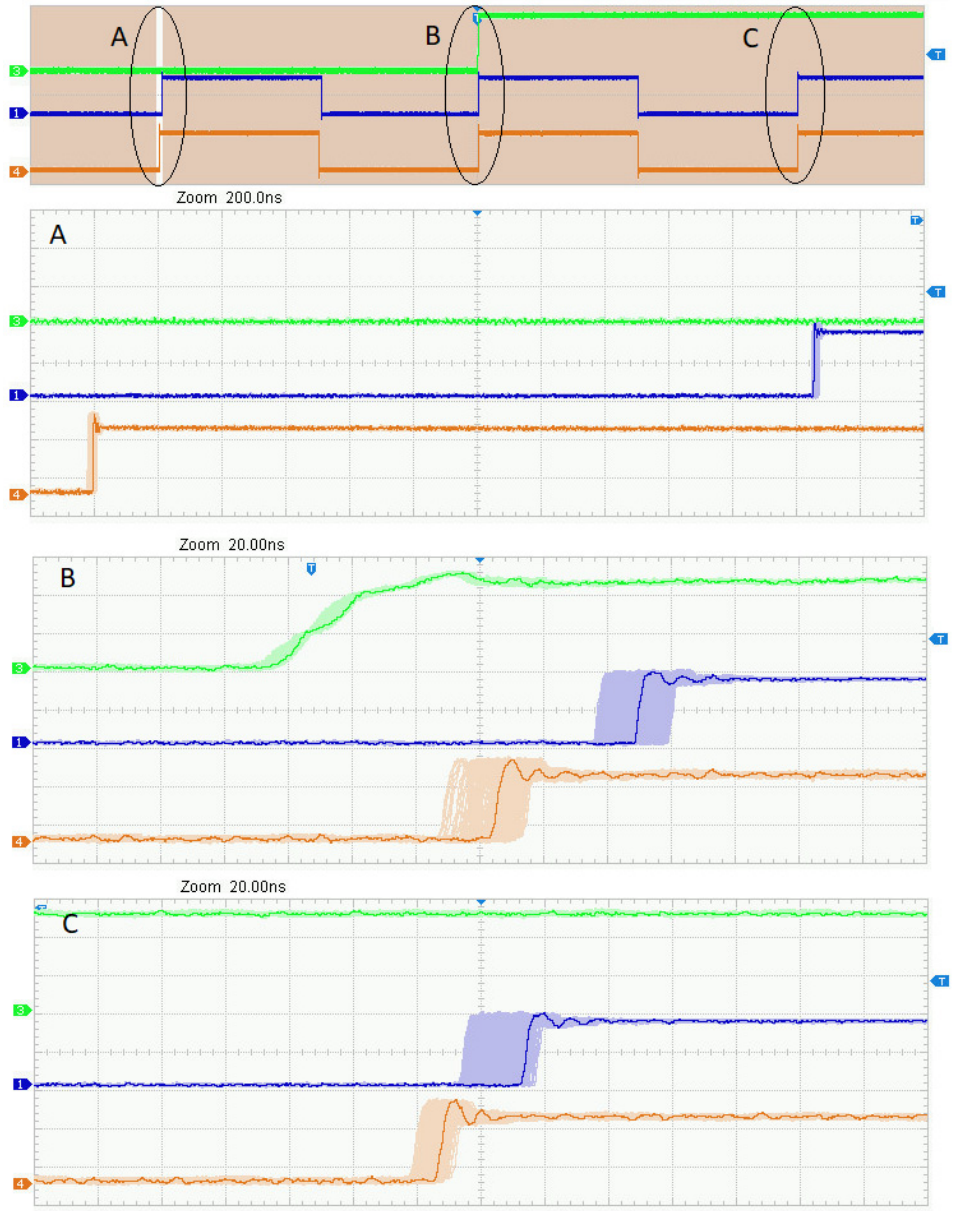
Figure 11. Rising edge comparison of sampling clock around PPS signal. A —sampling edge before PPS, B —first sampling edge after PPS, C —second sampling edge after PPS. Channel 4 (orange)— PMU-B, channel 1 (blue)—PMU-A, channel 3 (green)—PPS.